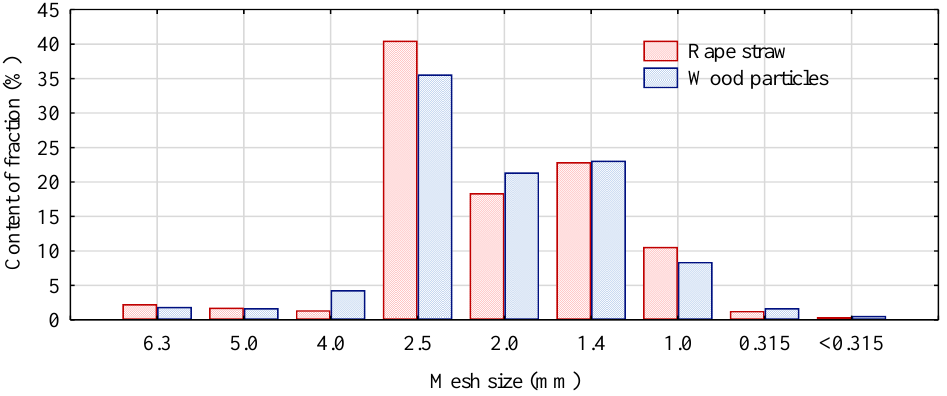
Figure 3. Fractional composition of rape straw particles and wood particles.